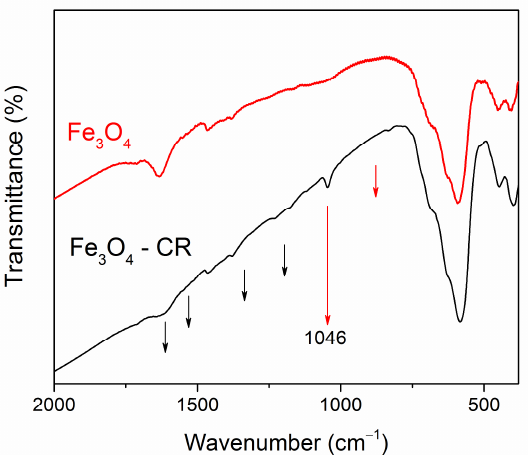
Figure 12. FT-IR spectra of Fe 3 O 4 NPs before and after adsorption of CR. The black arrows indicate the position of the CR features, which correspond to data of Ref. [64] . The red lines indicate the positions of new lines in the spectrum of the Fe 3 O 4 @C nanoparticle after dye adsorption, correlating with data of Ref. [19].